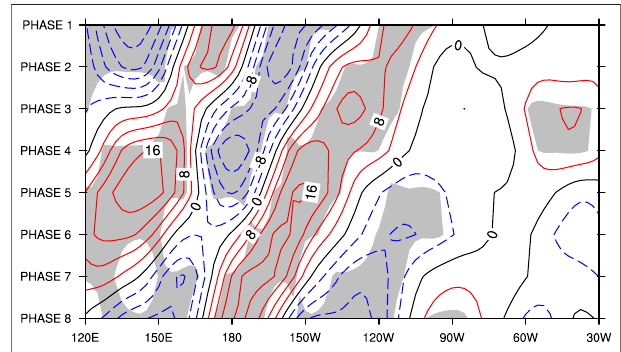
FIGURE 4 | Phase-longitude cross section of 10 – 30 days fi ltered of Z500 (unit: gpm) along 30 ° – 60 ° N (shaded regions are signi fi cant at 95% con fi dence level).